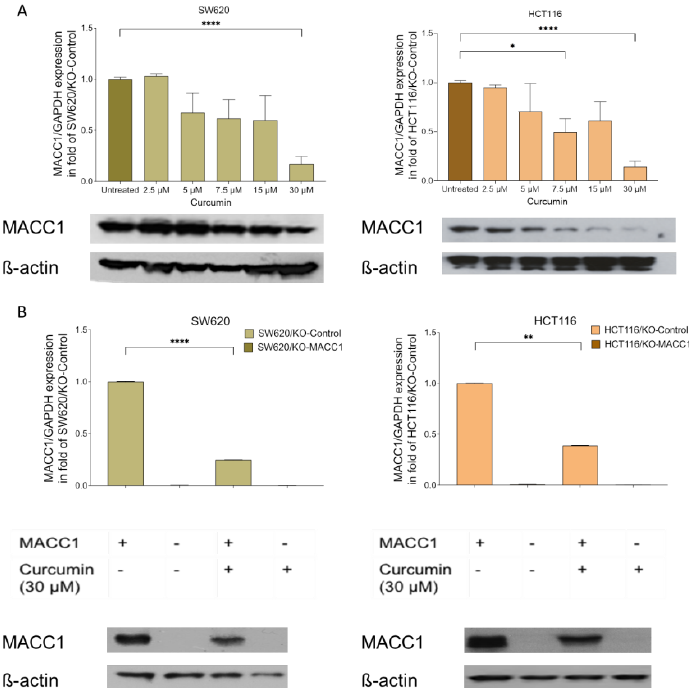
Figure 1. Curcumin treatment reduced the metastasis-associated in colon cancer 1 (MACC1) expres- sion. Colorectal cancer (CRC) cells SW620 and HCT116 cells were treated with various concentrations of curcumin. MACC1 mRNA expression was determined by qRT-PCR, and protein levels were detected with Western blot analysis. MACC1 mRNA and protein levels decreased upon increasing curcumin concentration in both SW620 and HCT116 cells ( A ). The same experiment was performed using the MACC1 knock-out clones, whereas the curcumin treatment did not impact the knock-out clones ( B ). MACC1 mRNAs were normalized with GAPDH. ß-actin has been used as a loading con- trol for the Western blot analysis. Data represent mean ± SEM ( n ≥ 3), * = p < 0.05, ** = p < 0.01, **** = p < 0.0001.